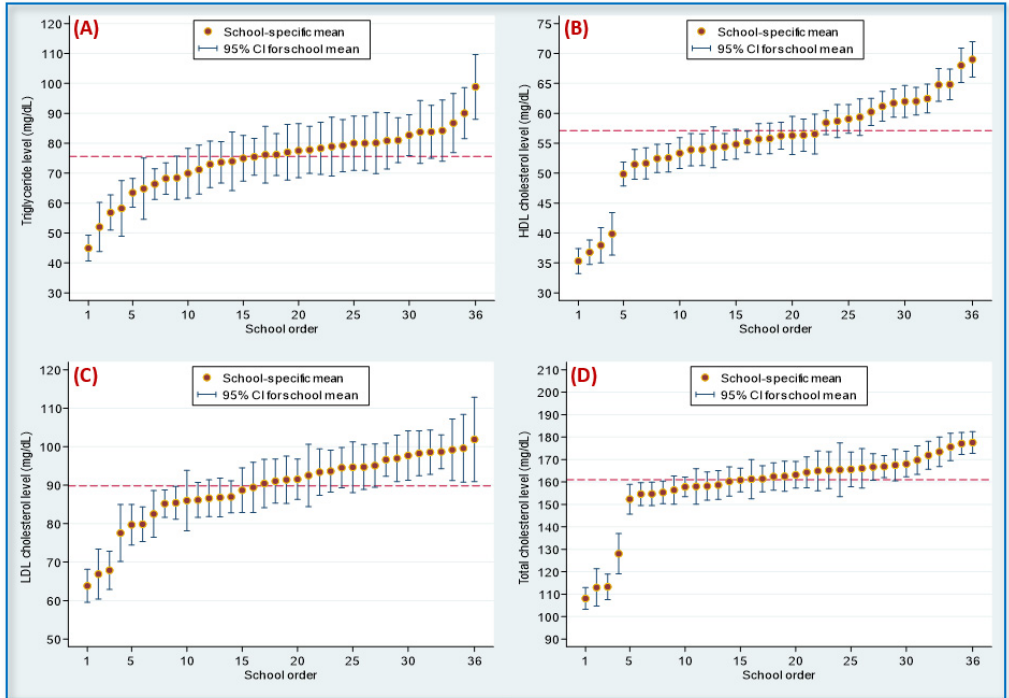
Figure 2. Caterpillar plots for the distribution of serum lipids among adolescents in 36 studied schools: ( A ) triglyceride; ( B ) high-density lipoprotein (HDL) cholesterol; ( C ) low-density lipoprotein (LDL) cholesterol; ( D ) total cholesterol. Note. School-level random-intercept effects for the 4 lipids were significant (all p -values were < 0.001). The dashed line represented the overall mean: 75.6 mg/dL for triglyceride, 57.1 mg/dL for HDL cholesterol, 89.8 mg/dL for LDL cholesterol, and 161.0 mg/dL for total cholesterol. CI, confidence interval.